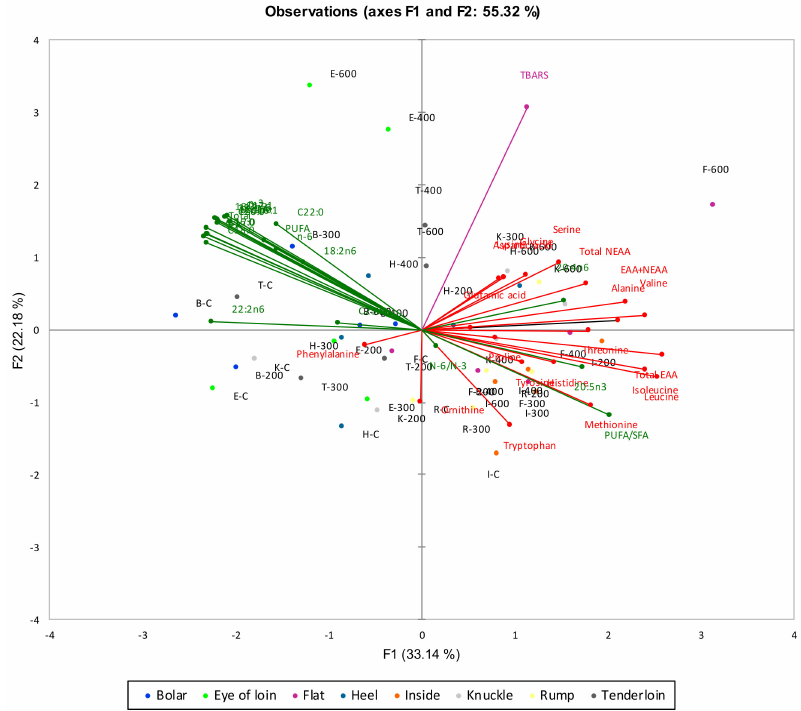
Figure 2. Multiple factor analysis (MFA) biplot for amino acids (red) and free fatty acids (green) for samples varying in cuts and HPP treatments. F1 (33.14%) and F2 (22.18%) explained a total of 55.32% of the